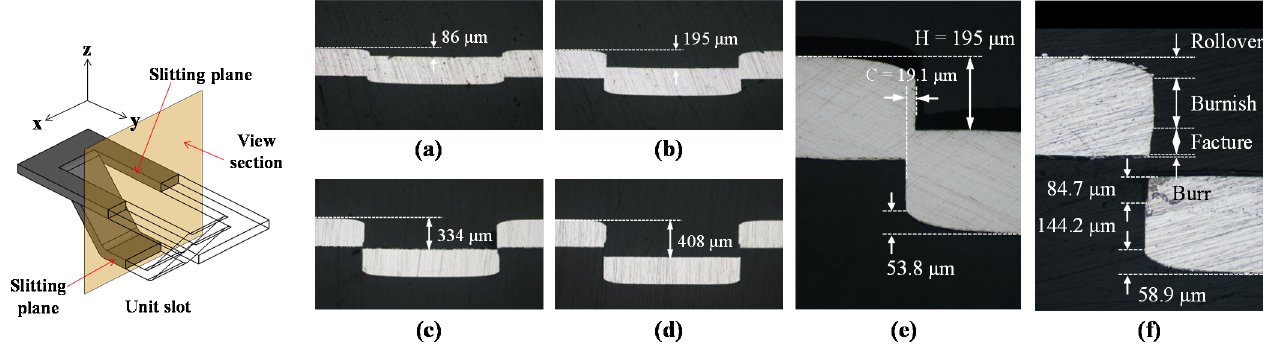
Figure 3. Cross-sectional shapes of slots according to forming height: ( a ) 86 μ m, ( b ) 195 μ m, ( c ) 334 μ m, and ( d ) 408 μ m; ( e ) magnified view of ( b ), and ( f ) magnified view of ( d ).